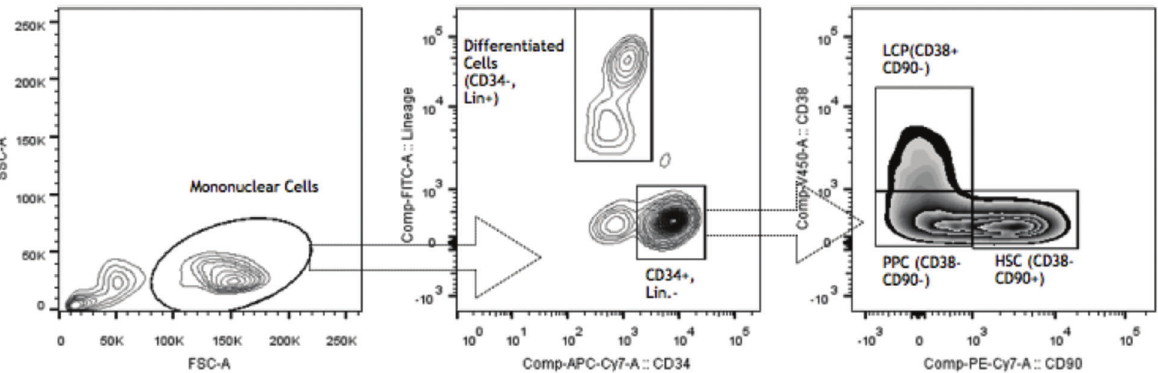
Figure 1. Gating Strategy. LCP: lineage committed progenitors; PPC: pluripotential progenitor cells; HSC: hematopoietic stem cells.